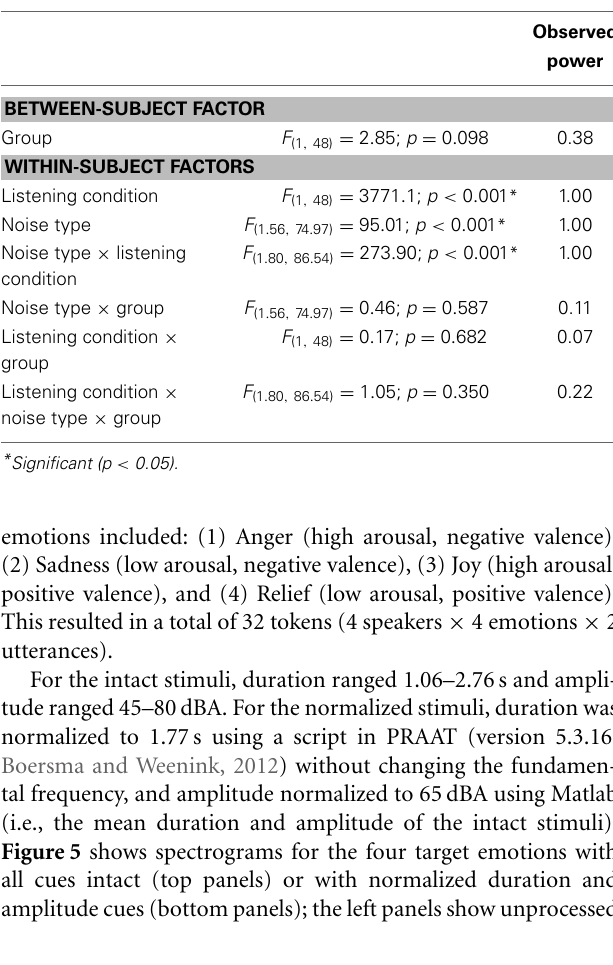
Table 3 | Experiment 1: Results of a split-plot ANOVA (with Greenhouse-Geisser correction) for sentence